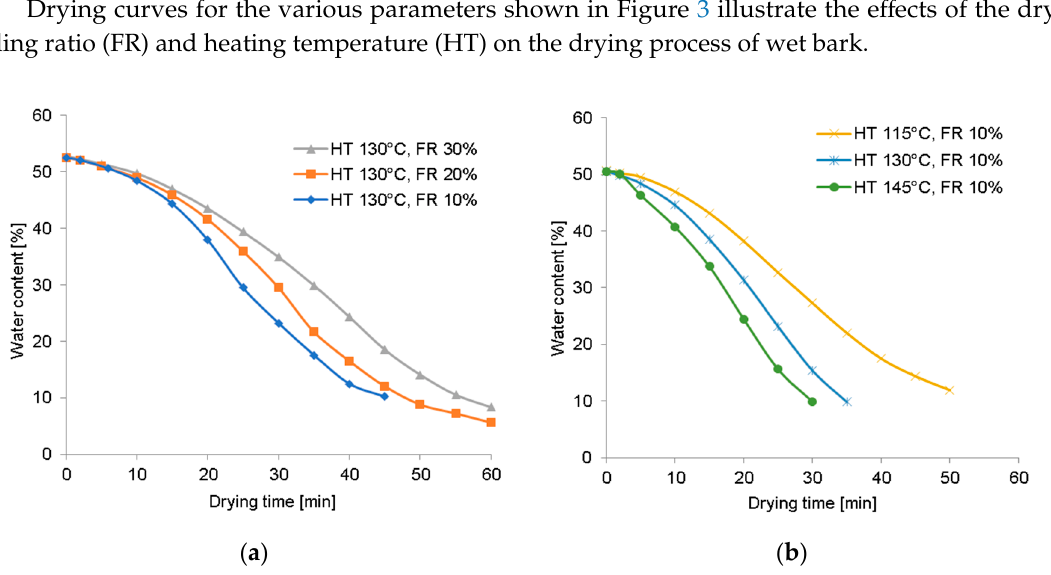
Figure 3. Drying curves: (a) For various filling ratios (FR); (b) For various heating temperatures (HT).